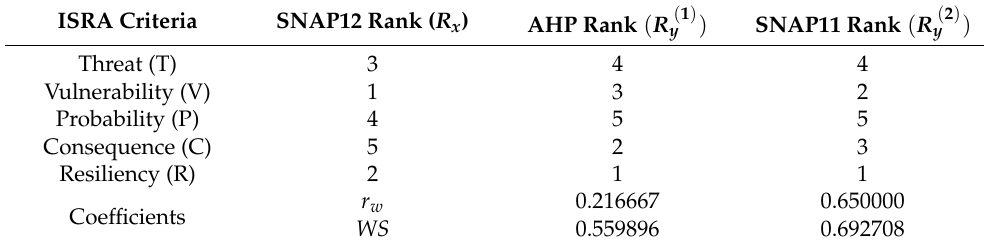
Table 4. Summary of reference rankings ( R x ) for ISRA criteria. ISRA Criteria SNAP12 Rank ( R x ) AHP Rank ( R ( 1 )